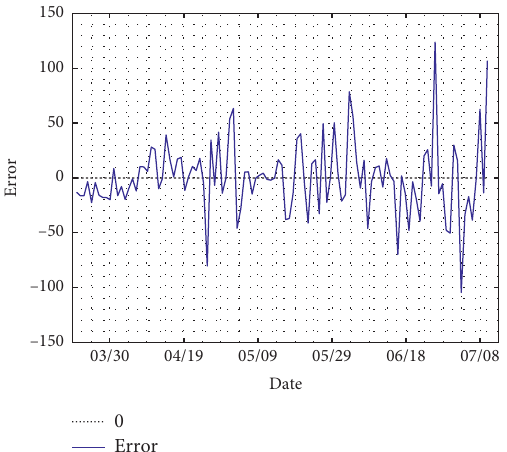
Figure 18: The fitting error of Mexico with a mean absolute error of